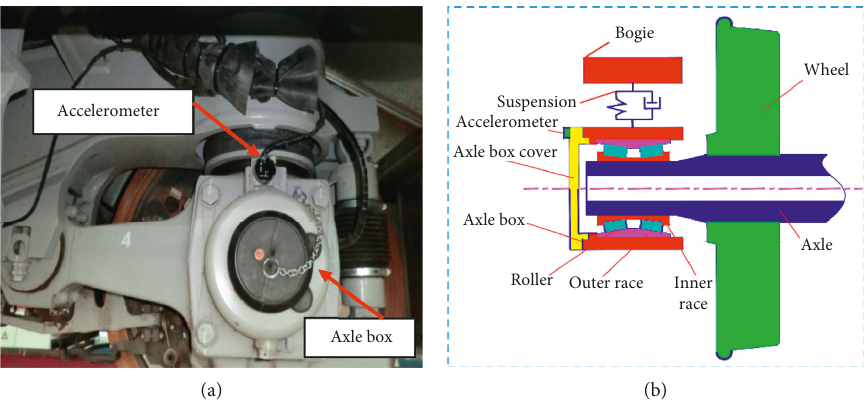
Figure 32: (a) Measurement sensor installed on the axle box cover; (b) structure diagram of the wheelset